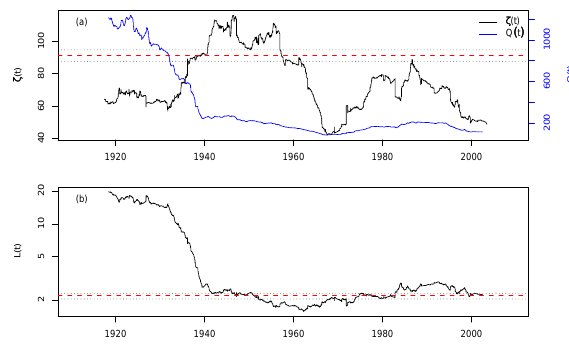
Fig. 5. (a) Q 2 (t) of the geomagnetic data (blue line). Mean squared daily deviation ( ζ 2 (t) ) of Z (black line). The confidence intervals are computed for the mean squared daily deviation ζ 2 (t) between 1940 and 2008. (b) L 2 (t) of the geomagnetic data with 2 = 11 years. The confidence intervals are determined for this pa- rameter between 1940 and 2008 (vertical line).